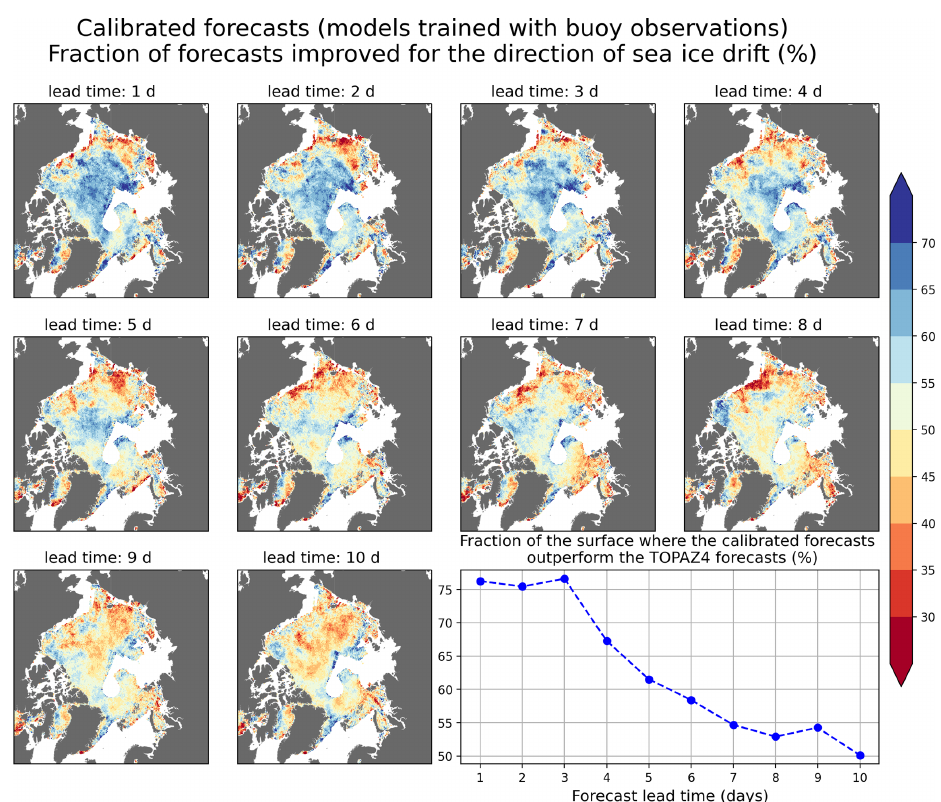
Figure 4. Fraction of calibrated forecasts produced by the models trained with buoy observations which outperform the TOPAZ4 forecasts for the direction of sea ice drift during the period from June 2020 to May 2021. Daily SAR observations have been used as reference. The graph in the lower right corner shows the fraction of the surface where the fraction of calibrated forecasts outperforming the TOPAZ4 forecasts is higher than or equal to